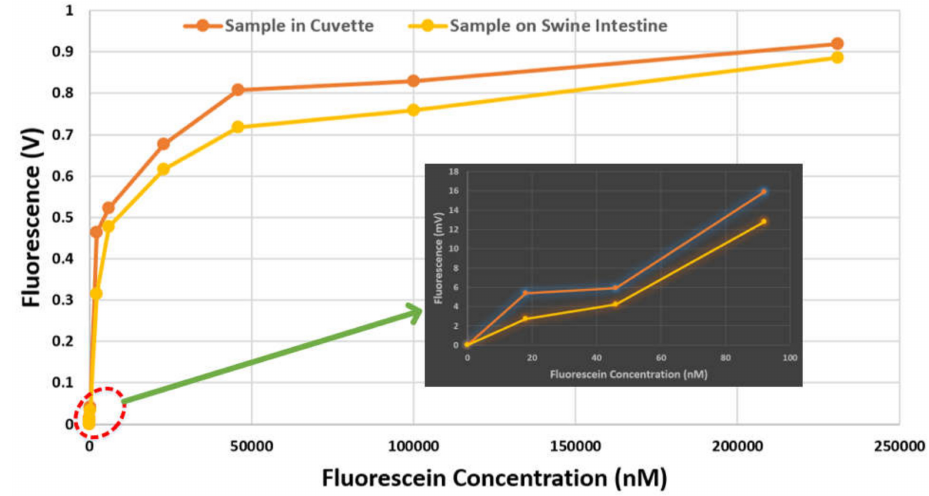
Figure 8. Change of fluorescence intensity with varying fluorescein concentrations. Inset: zoomed plot when the concentration is